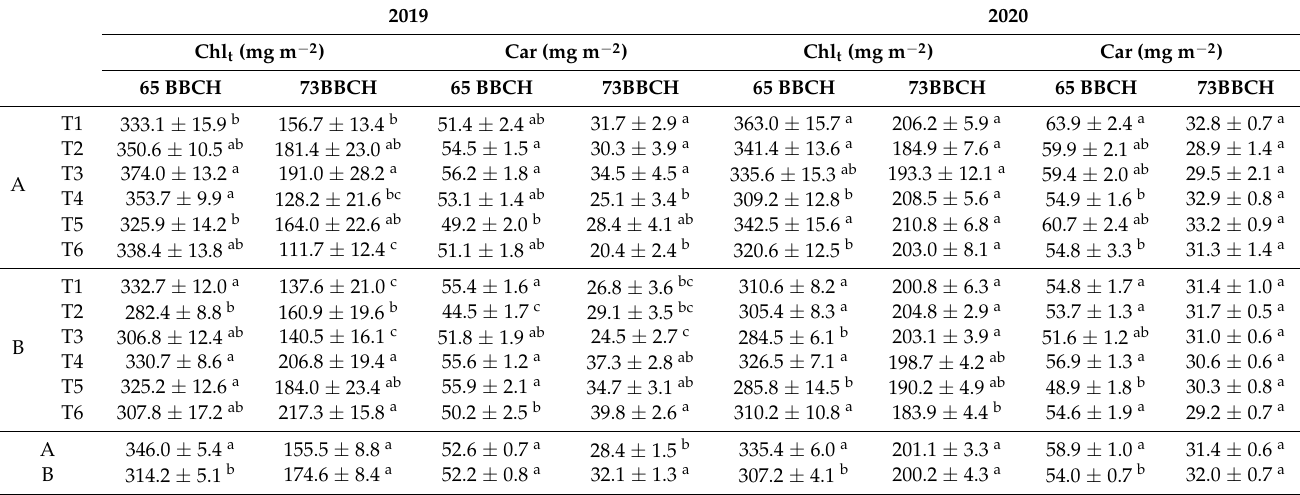
Table 3. Total chlorophylls (Chlt) and carotenoids (Car) in the cultivar with blue aleurone KM- 72-18 (A) and multi-rowed spike KM-94-18 (B) in the developmental phases 65 and 73 BBCH in single vegetation treatments (T1–T6). Means ± SE; n = 10; LSD post hoc test. Different letters differ significantly at p <